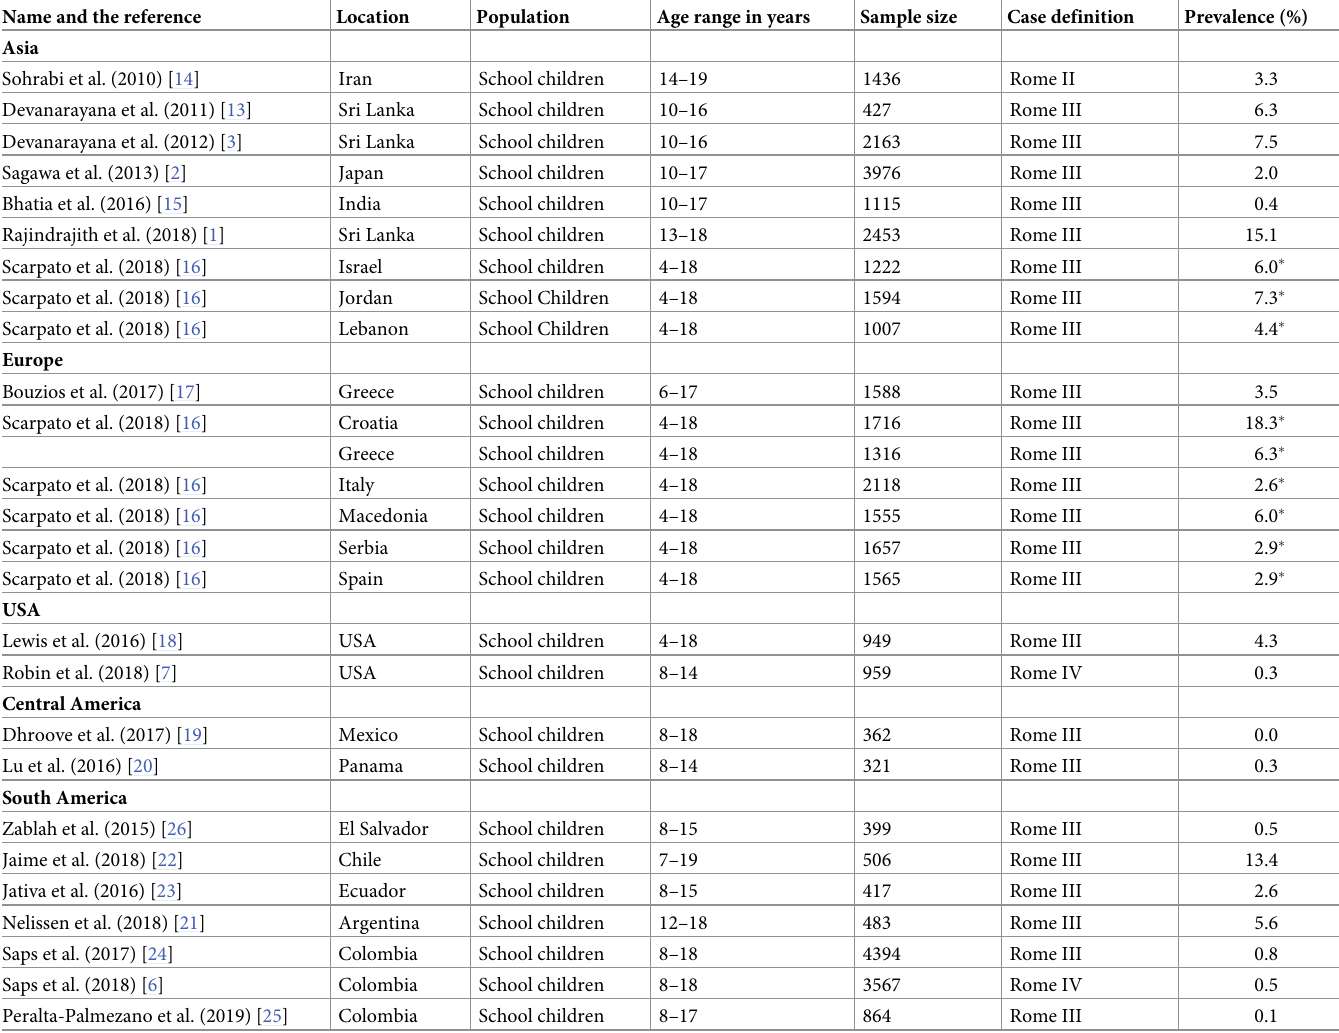
Table 1. Characteristics of the selected